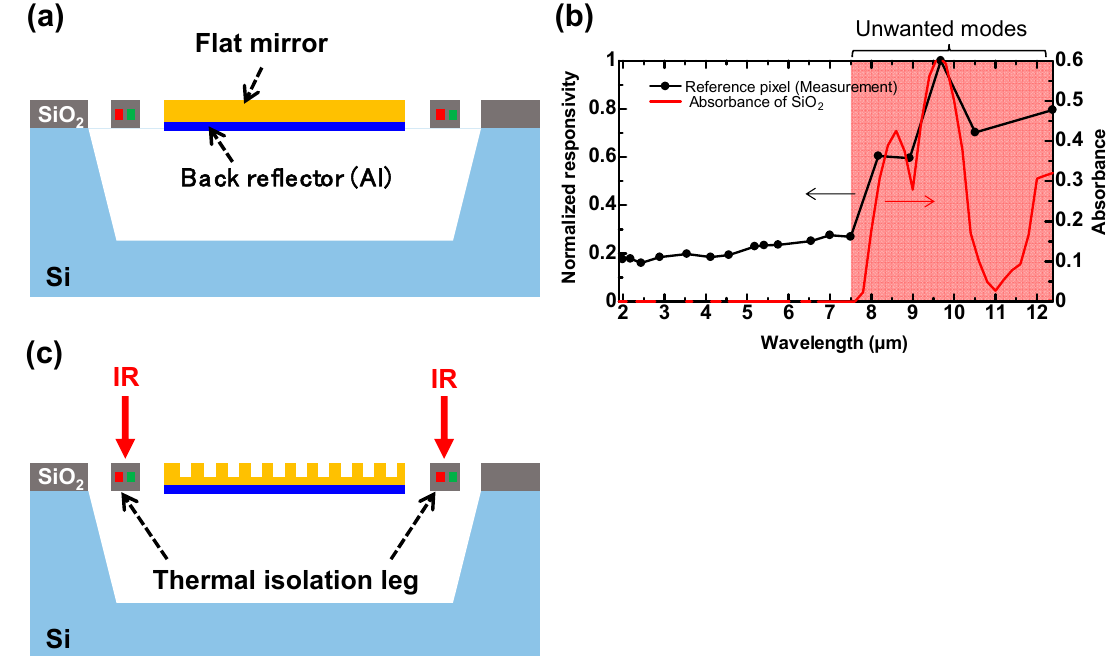
Figure 2. ( a ) Schematic illustration of a typical MEMS-based thermopile with flat mirror (reference pixel) and ( b ) its measured spectral responsivity and calculated absorbance of 1.5 µ m thick SiO 2 . ( c ) Schematic illustration of unwanted absorption by the SiO 2 -thermal isolation legs in typical MEMS-based uncooled IR sensors.